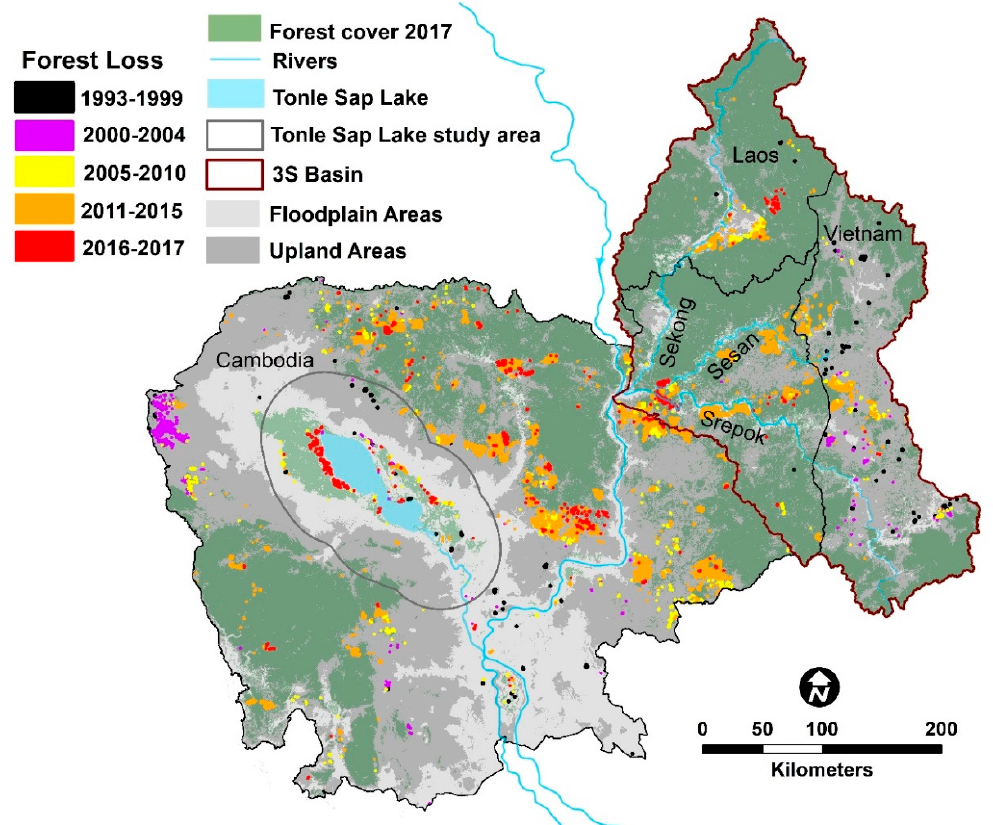
Figure 5. Forest loss in Cambodia and the 3S Basin from 1993 to 2017.